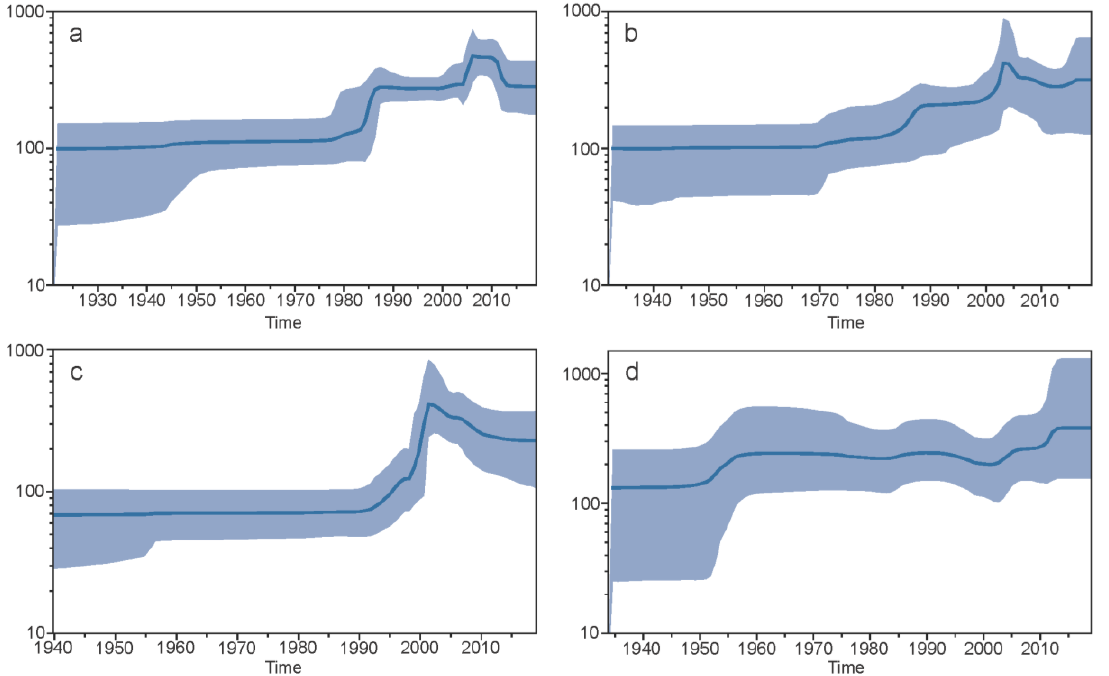
Figure 7. Demographic evolutionary history of whole genome epidemic isolate datasets for DENV1 ( a ), DENV2 ( b ), DENV3 ( c ), and DENV4 ( d ). The blue line represents the mean posterior value, and the shaded area represents the 95% HPD intervals. Time in years is found on the x -axis, and the y -axis is the log of the effective population size.